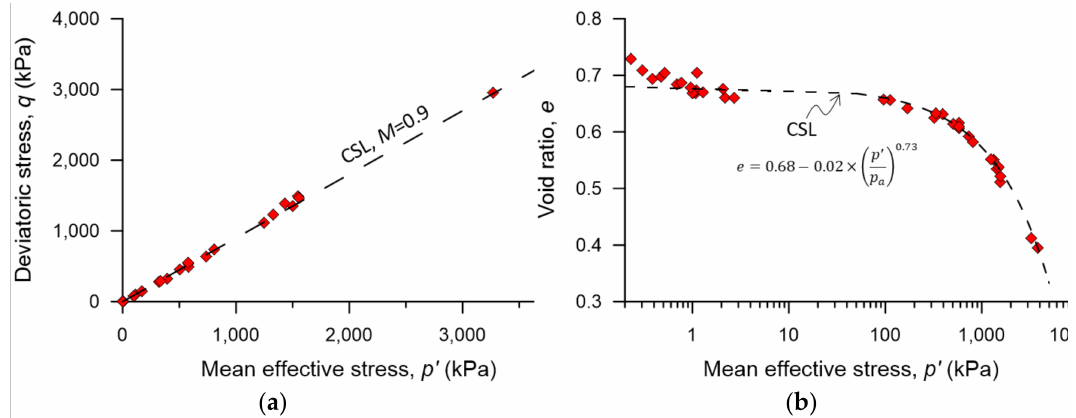
Figure 4. The classical critical state line from the undrained simulations in ( a ) q - p (cid:48) and ( b ) e -log( p (cid:48) )